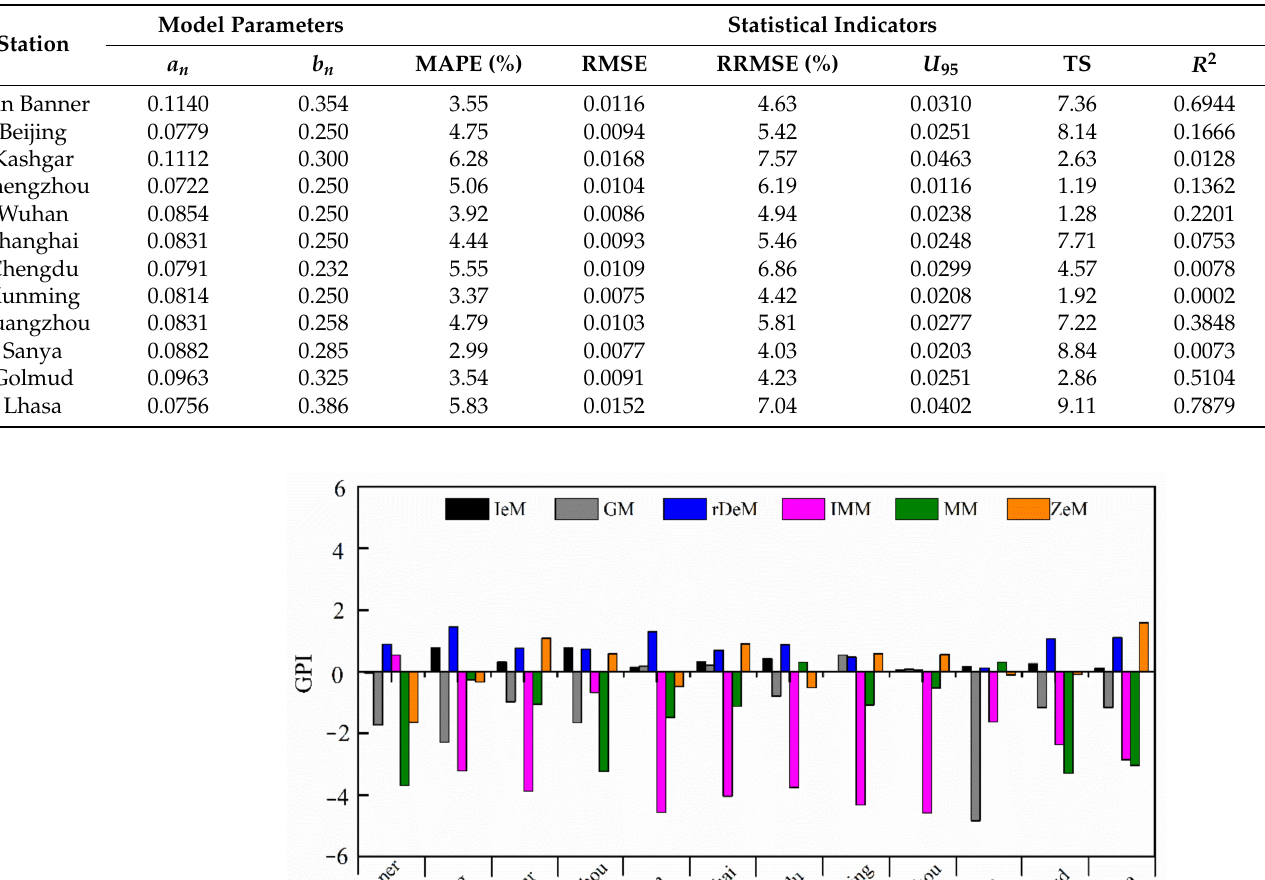
Table 3. Calibrated values of rDeM parameters for selected stations.